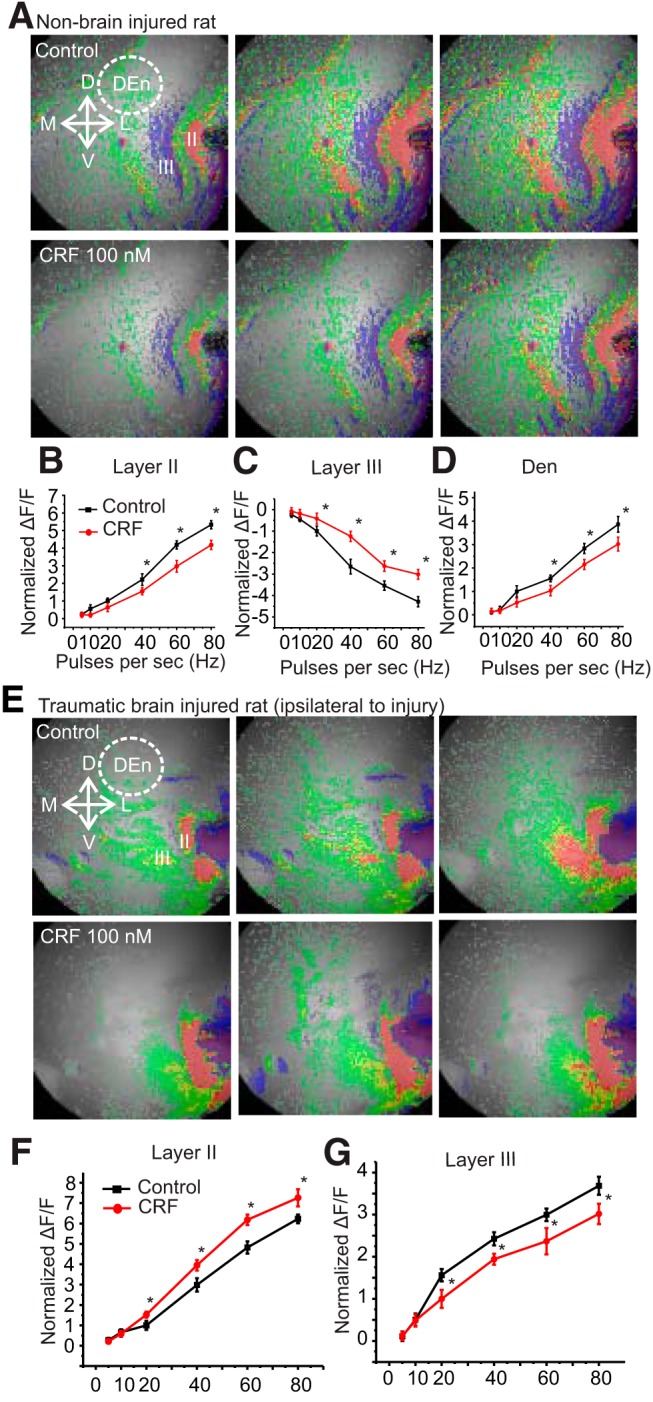

CRF application increased the activity of the PCtx in TBI rat. A, Representative images showing activation of PCtx from sham rats, without (top) or with CRF (100 nM; bottom). Each image was taken at the same time interval [2 (during stimulation), 3, and 5 s]. B–D, Quantification of CRFR1 activation shows that the activity of Layer II pyramidal cells and interneurons of DEn are decreased while the activity of Layer III interneurons is increased in non-brain-injured animals over the range of stimulation frequencies used to activate the circuit; *p < 0.05; n = 5 slices from four rats. E, Representative images showing activation of the layers of ipsilateral PCtx from brain-injured rats, without (top) or with CRF bottom). F, G, Quantification of CRFR1 activation shows that the activity of Layer II pyramidal cells is increased while the activity of Layer III interneurons is decreased over the range of stimulation frequencies used in piriform cortical slices from TBI rats to activate the circuit; *p < 0.05. n = 9 slices from seven rats. No response is observed from interneurons of DEn. Arrows in panels indicate the orientation of slice. D, dorsal; V, ventral; M, medial; L, lateral. Red indicates highest ΔF/F; orange, yellow and green indicate medium ΔF/F; blue a reduction in ΔF/F.